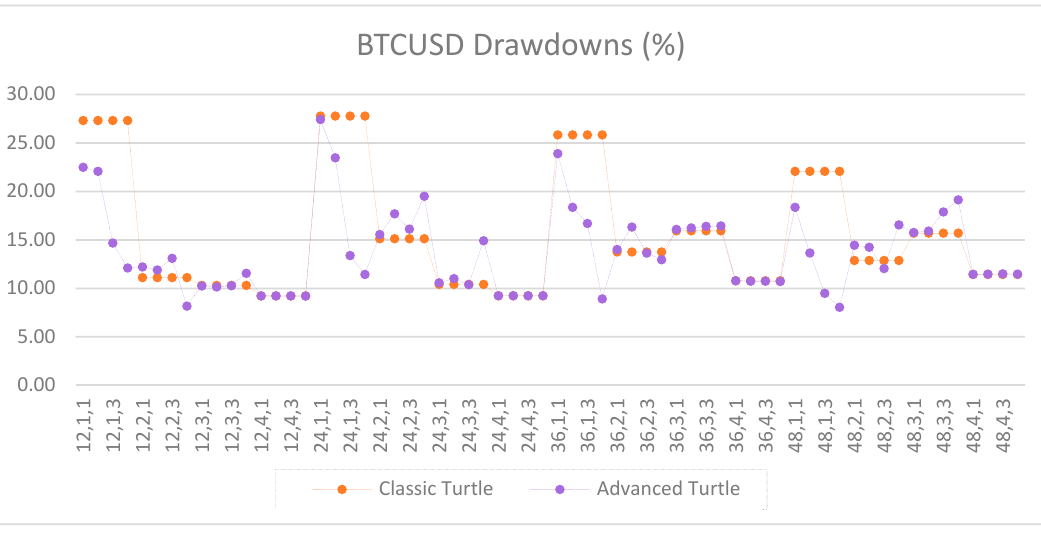
Figure A16. Drawdowns of BTCUSD as percentage of equity between the classic and the advanced Turtle systems for every combination of N, X, Y for the fast parameters (20, 40).